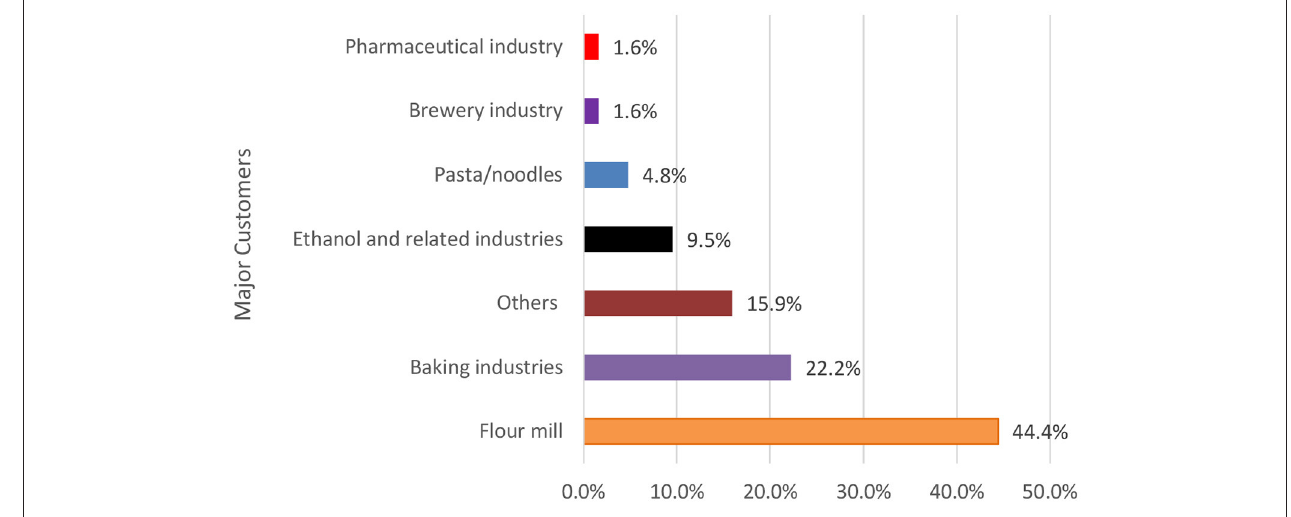
FIGURE 9 | Major buyers of high-quality cassava flour